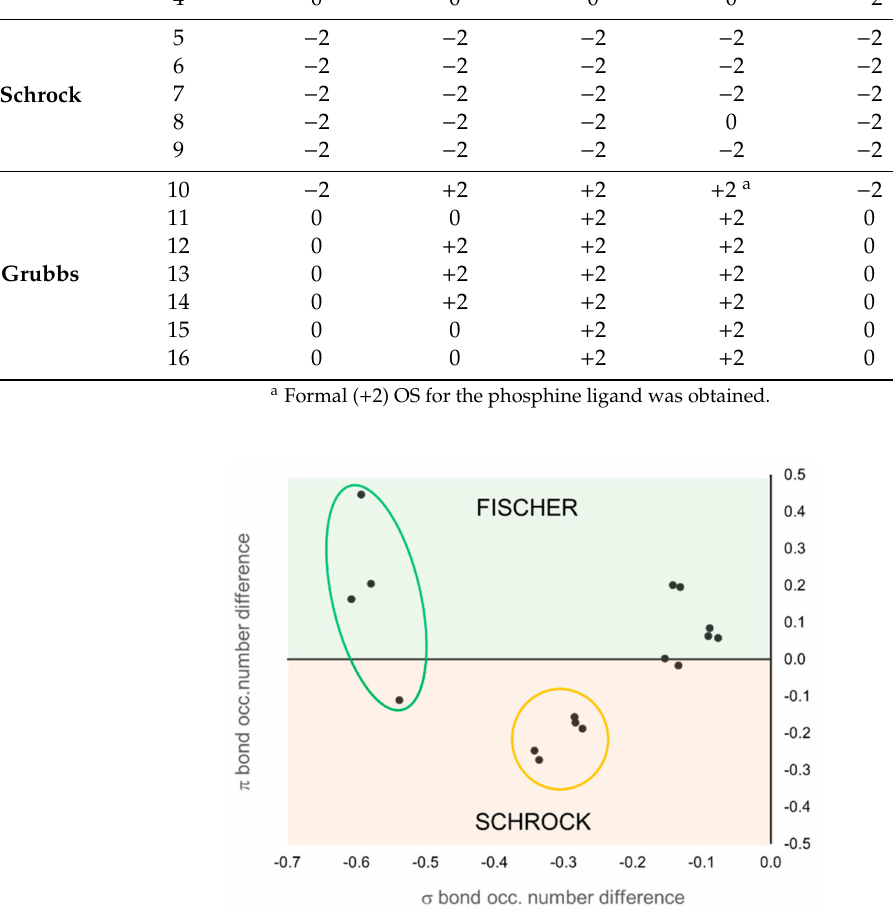
Figure 9. Classification of the TM carbenes according to the relative occupation number of the σ and π EFOs on the TM and the carbene moiety. Data points corresponding to 1–4 (green circle) and 5–9 (orange